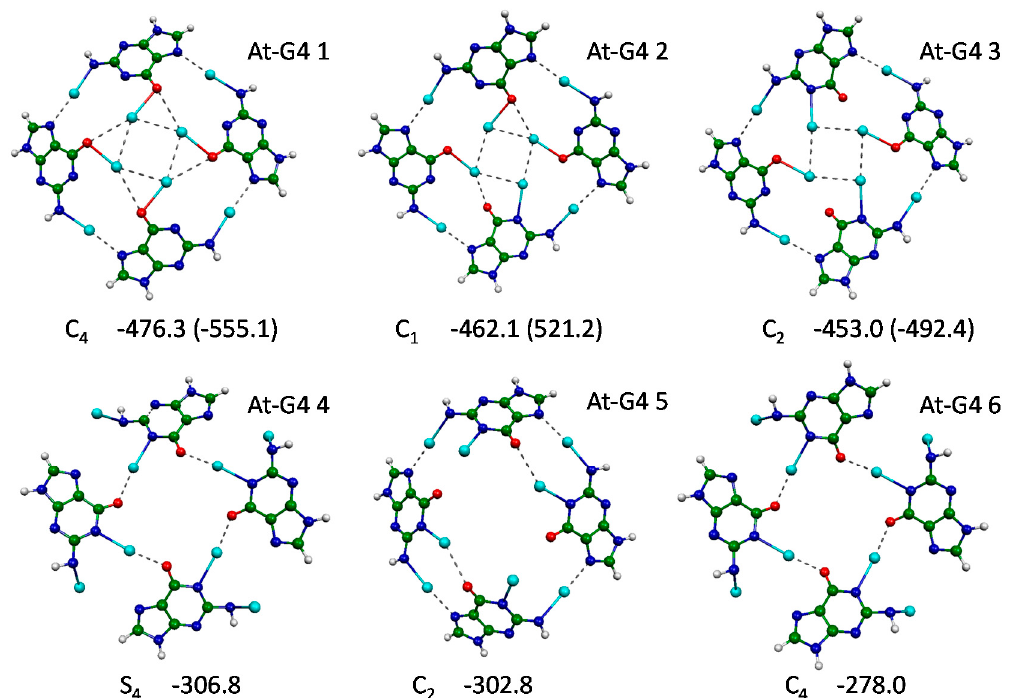
Figure 4. The optimised X-quartets (X = Cl, Br, I, At). The symmetry and interaction energy (in kJ/mol) are listed below the structure. The interaction energy in brackets is calculated with respect to four 1,6X-G monomers (for Cl-G4 4, Br-G4 5, and At-G4 1), three 1,6X-G monomers, and one 1,2X-G monomer (At-G4 2) or two 1,6X-G monomers and two 1,2X-G monomers (At-G4 3).